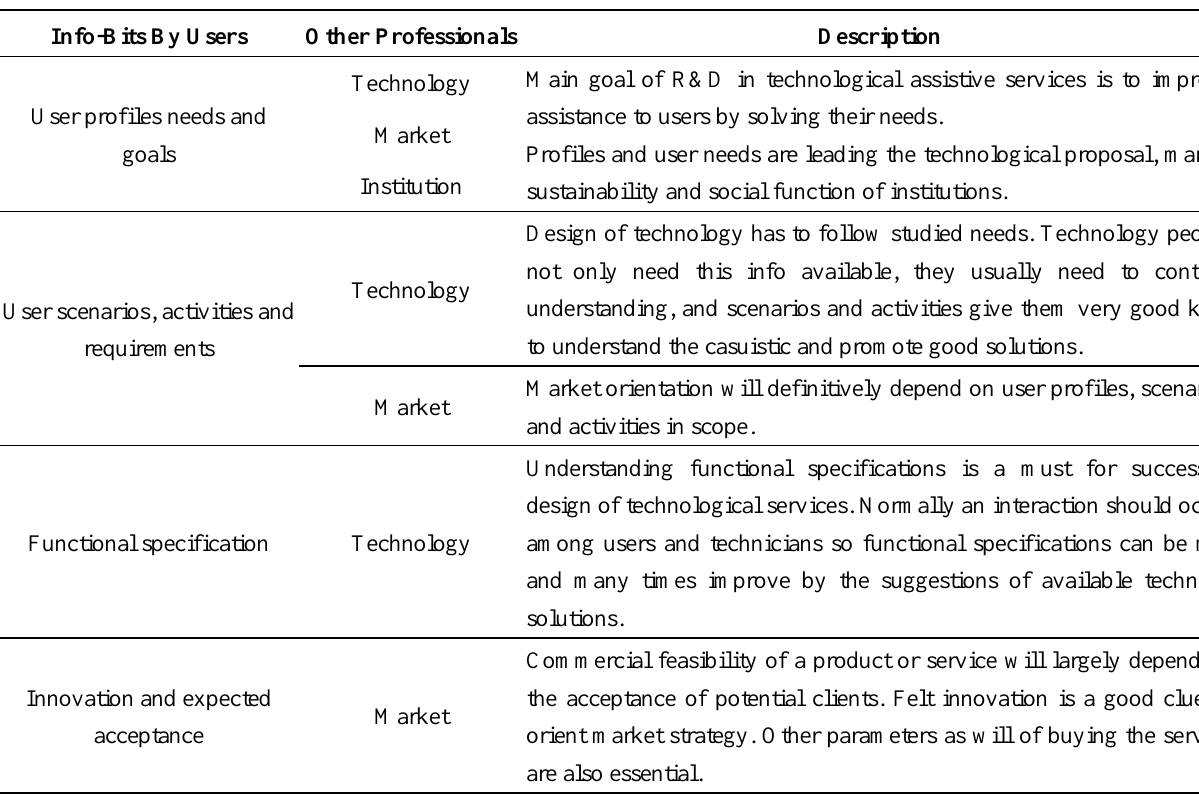
Table 1. Description of importance of information generated by user-oriented professionals as received by other